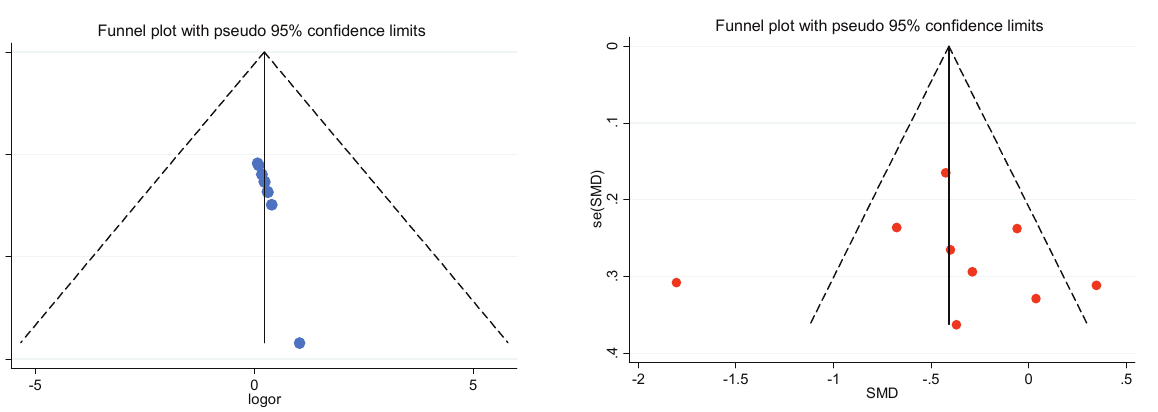
Figure 5: The Begg’s funnel plot for clinical efficacy of piribedil in adjuvant treatment of Parkinson’s Disease